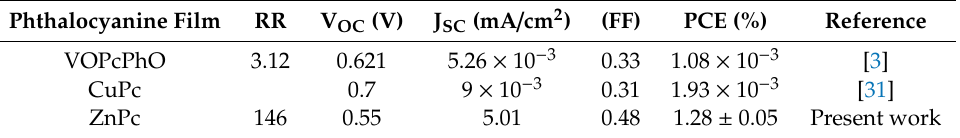
Table 3. Comparison of device parameters of ZnPc Schottky solar cell with previously fabricated single layer solar